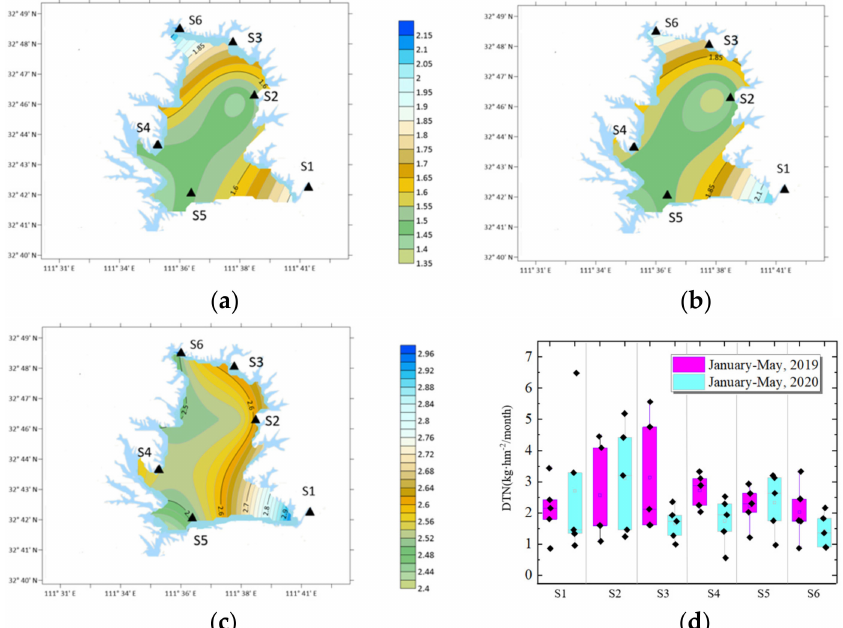
Figure 8. DTN distribution around COVID-19 lockdown. ( a ) Before lockdown; ( b ) Middle lockdown; ( c ) After lockdown; ( d ) DTN compared with